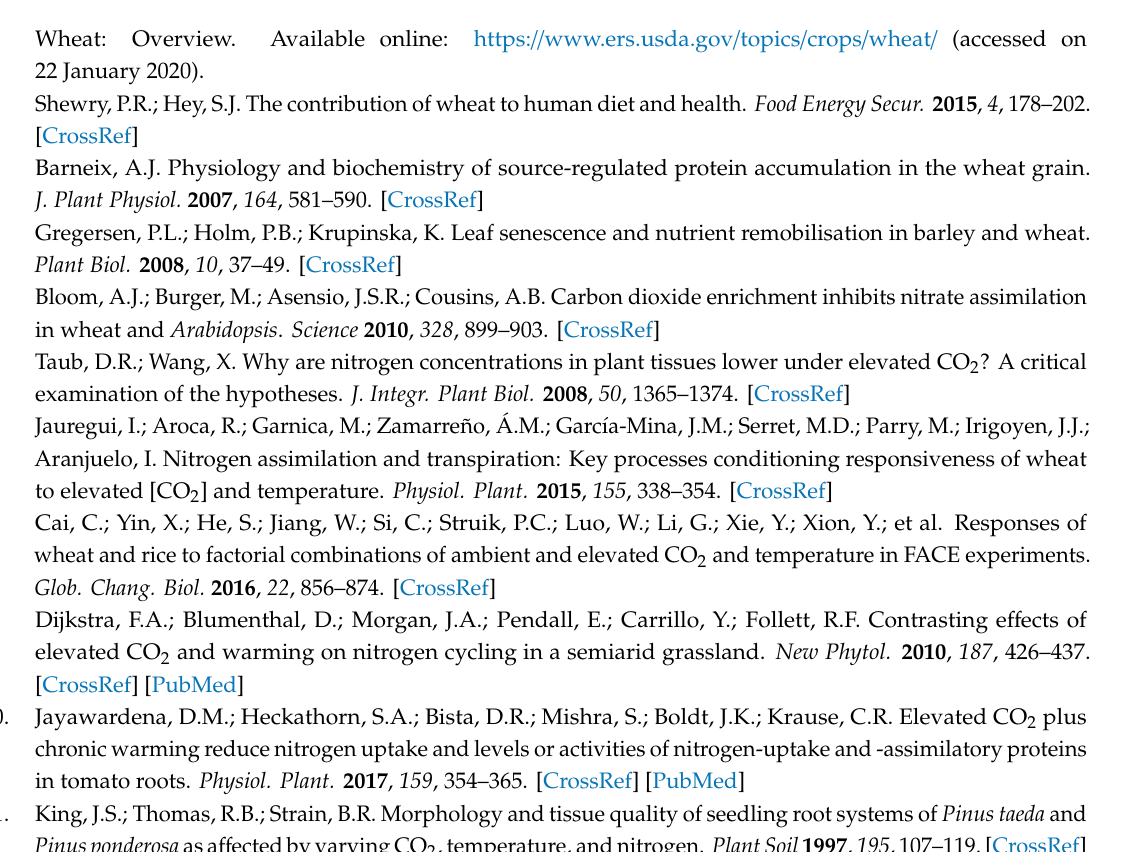
Figure S1: Timeline of di ff erent steps in plant growth, treatments, and harvest, Table S1: p -values from ANOVA statistical